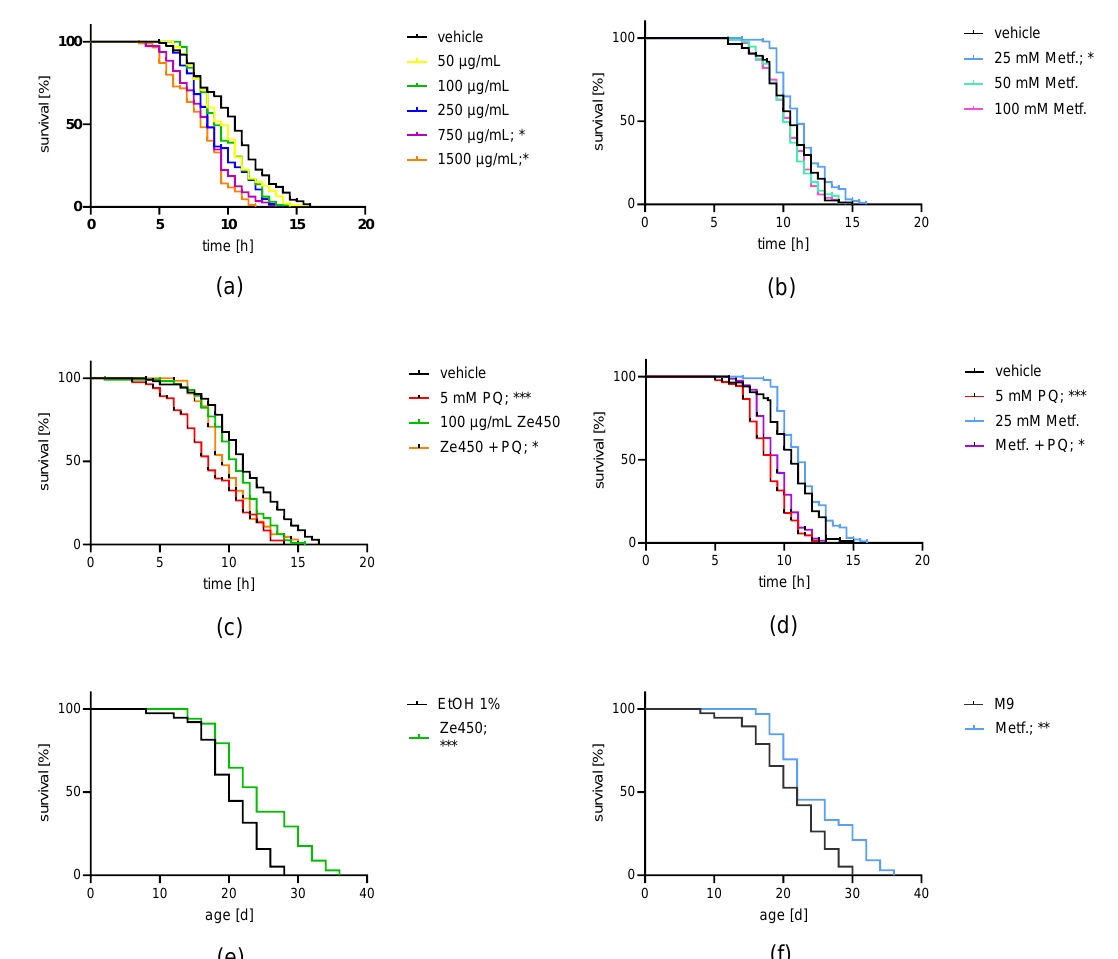
Figure 7. Effects of Ze 450 and metformin on C. elegans . ( a ) Effects of different concentrations of Ze 450 in a heat stress model system in C. elegans . The 50–250 µ g/mL Ze 450 did not affect the lifespan, while worms treated with 750 or 1500 µ g/mL showed a decrease in lifespan (* p < 0.05, n = 85–115). ( b ) Effects of metformin (25–100 mM) in a heat stress model system in C. elegans . 25 mM metformin improved lifespan (* p < 0.05 compared to M9 vehicle control), while treatment with ≥ 50 mM metformin did not affect lifespan ( n = 75–97). ( c ) Effects of 100 µ g/mL Ze 450 in a model system of paraquat (PQ) induced oxidative stress in C. elegans ( n = 65–113, *** p < 0.001 PQ compared to vehicle, * p < 0.05 Ze 450 + PQ compared to PQ). ( d ) Effects of 25 mM metformin in a model system of paraquat (PQ)-induced oxidative stress in C. elegans ( n = 76–97, *** p < 0.001 PQ compared to M9 vehicle, * p < 0.05 25 mM metformin +PQ compared to PQ). ( e ) Effects of 100 µg/mL Ze 450 on C. elegans in the real-time lifespan assay (*** p < 0.001 compared to vehicle; 1% ethanol). ( f ) Effects of 25 mM metformin on C. elegans in the real-time lifespan assay (** p < 0.001 compared to vehicle; M9).